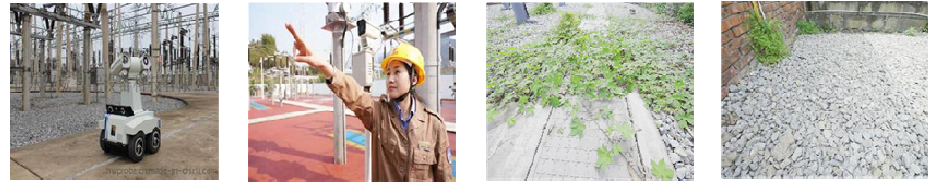
Figure 8. Main obstacle types.